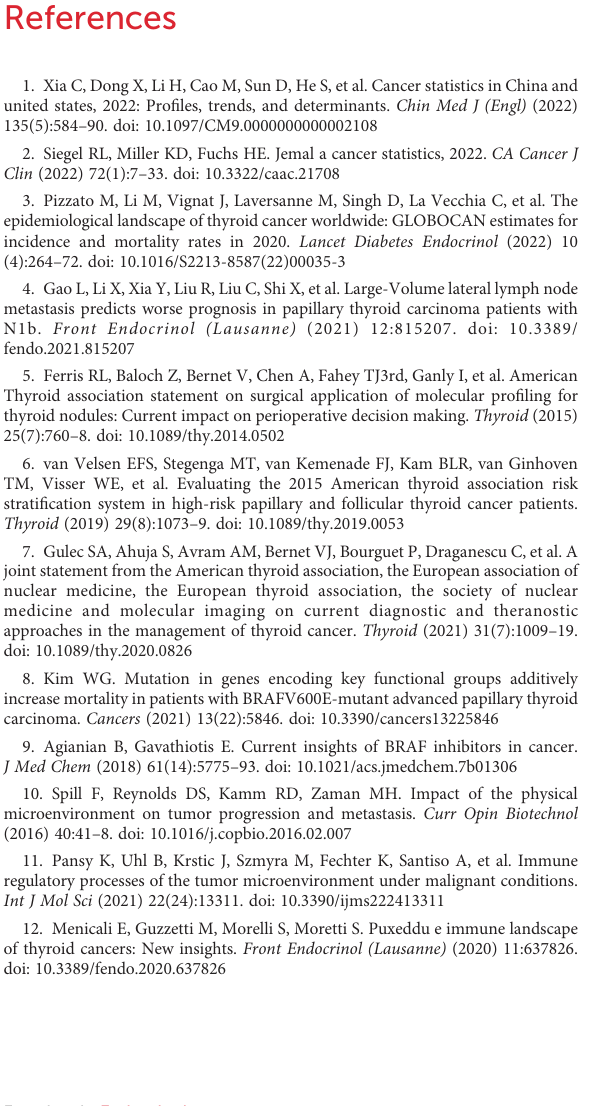
SUPPLEMENTARY FIGURE 1 The dot plot of cell markers and cell-cell communications in thyroid cancer. (A) The dot plot of cell markers for different cell clusters. (B)